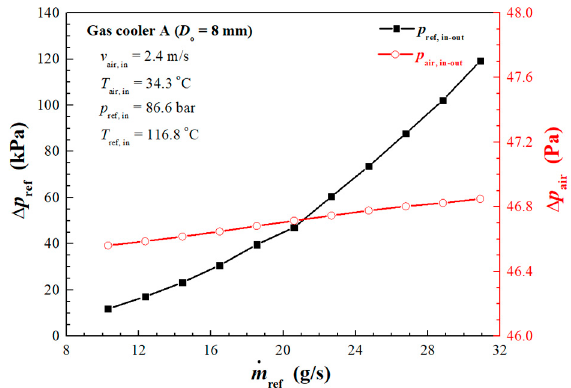
Figure 9. Influence of refrigerant mass flow rate on pressure drop of sCO 2 and air for gas cooler A.